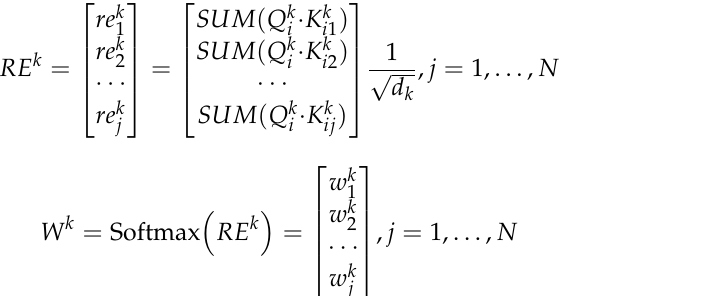
Figure 5. Region of Interest (ROI) pooling module and detection head.